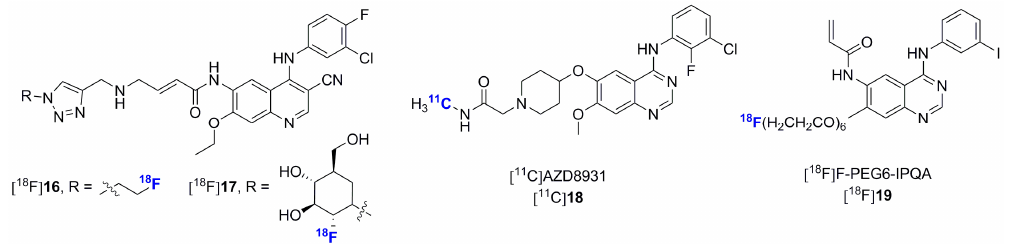
Figure 7. Chemical structures of recently identified and evaluated ErbB-1/ErbB-2/ErbB-3 kinase